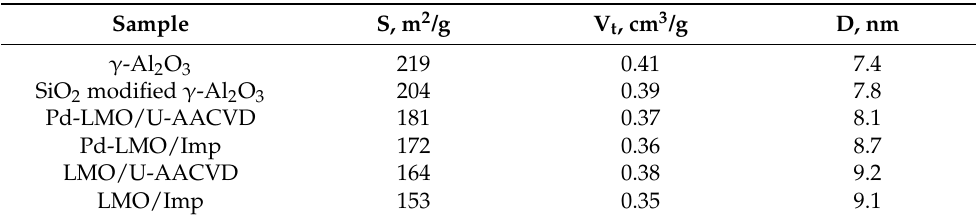
Table 2. Specific surface area (S), total pore volume (V t ) and mean pore diameter (D) for γ -Al 2 O 3 , SiO 2 -modified γ -Al 2 O 3 , Pd-LMO/U-AACVD and Pd-LMO/Imp. For comparison, the corresponding